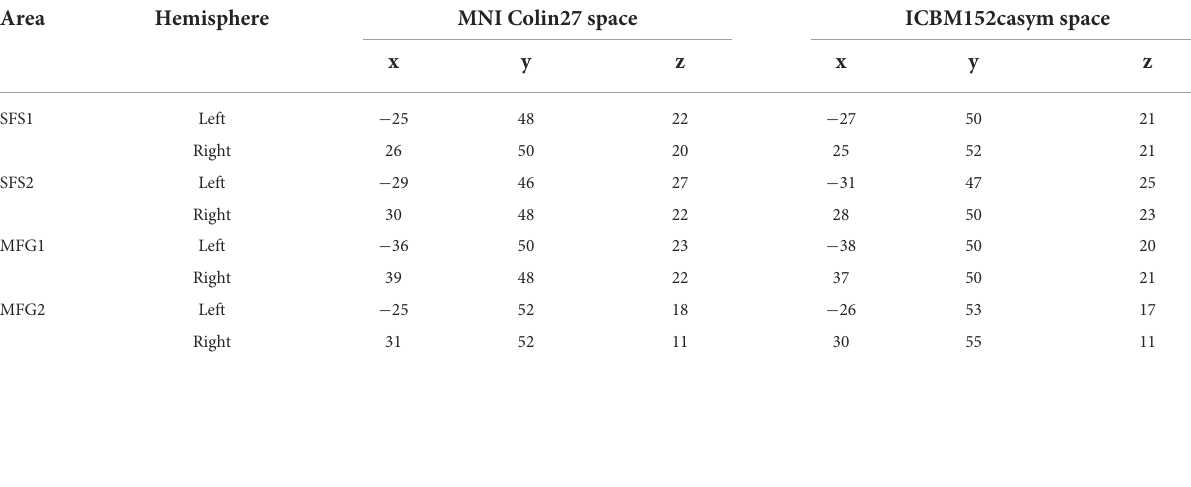
TABLE 3 Center of gravity coordinates in anatomical MNI Colin27 and MNI ICBM 152 space of anterior DLPFC areas separated by hemisphere. Area Hemisphere MNI Colin27 space ICBM152casym